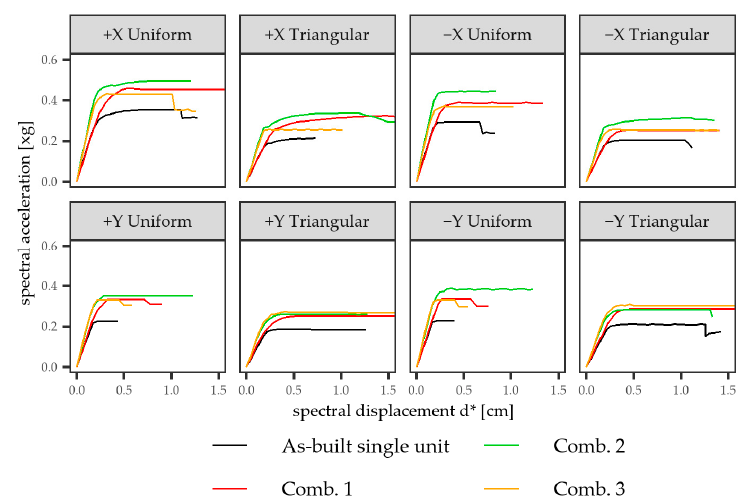
Figure 14. Single-unit model: normalized pushover analyses in strengthened conditions, compared to as-built.